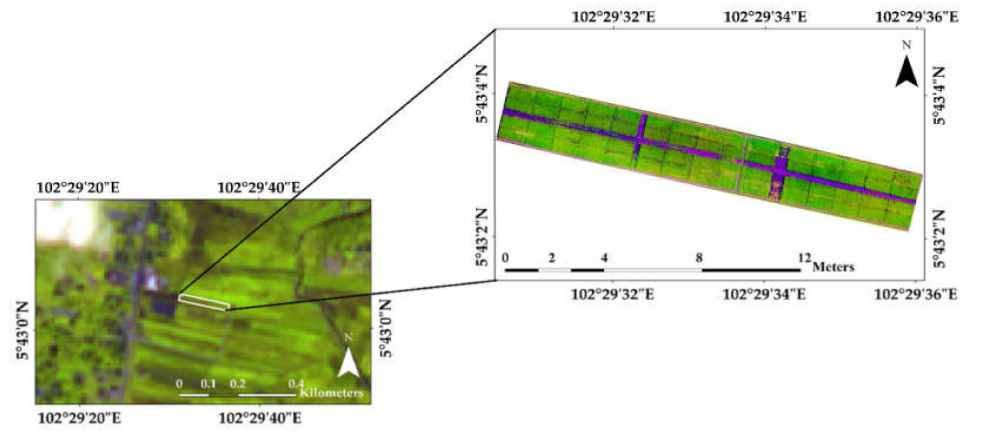
Figure 1. Study area in Sentinel-2 (R:5, G:8, B:5) and UAV-mounted MicaSense Red-Edge multispec- tral camera (R:4, G:5, B:3)